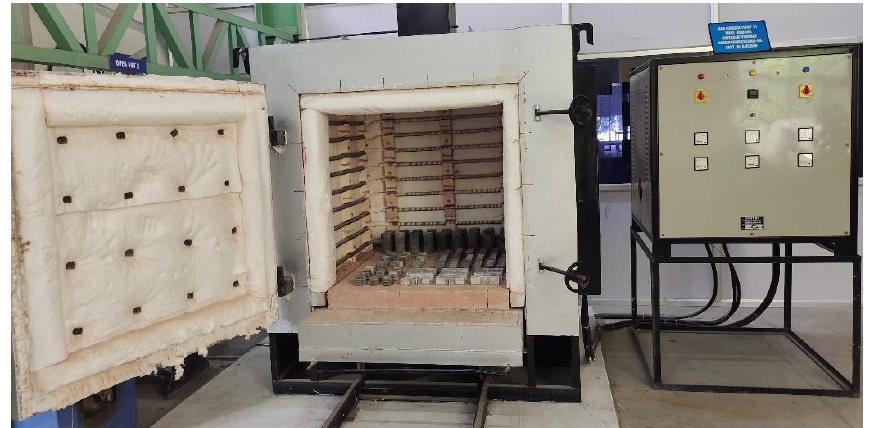
Figure 13. Specimens placed in the box furnace.